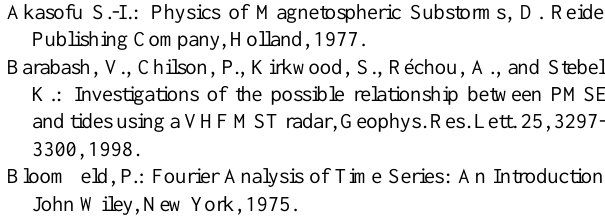
daily variation which is of particular interest is the deep min- imum in PMSE between 19:00 and 22:00 UT (see Fig. 1).